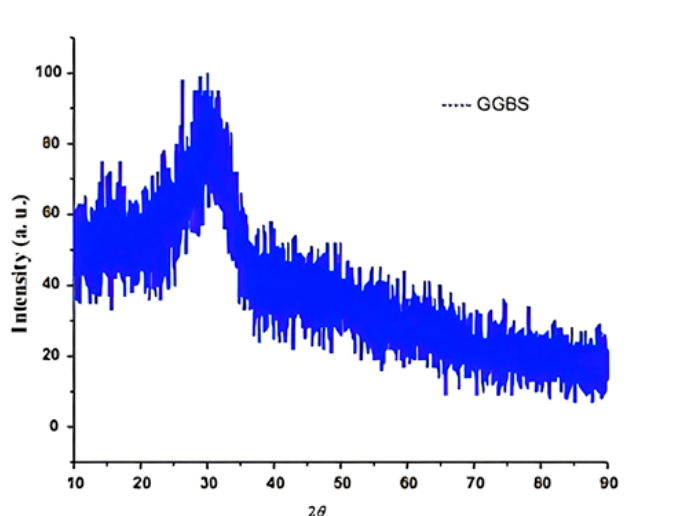
Table 2. Ratios of various sand fraction sizes conforming Zone II. Sieve Size